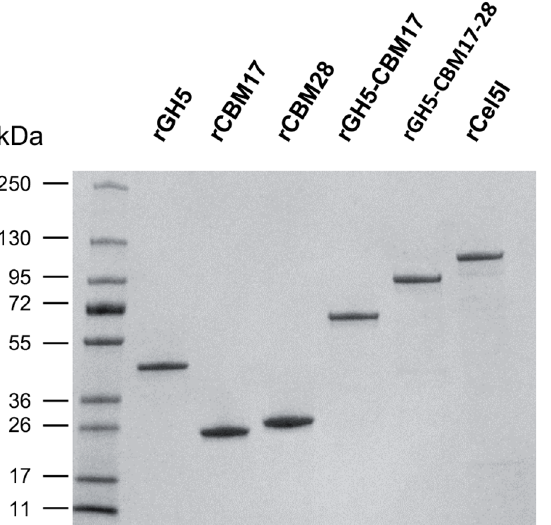
Fig 2. Purified recombinant derivatives of Cel5I. Purified proteins (2 μ g) were loaded on SDS-PAGE, and Coomassie blue stained. Migration of recombinant proteins was in good agreement with theoretical molecular mass rGH5 (41 kDa); rCBM17 (20.6 kDa); rCBM28 (22,5 kDa); rGH5-CBM17 (59 kDa), rGH5-CBM17-28 (80 kDa), and rCel5I (99